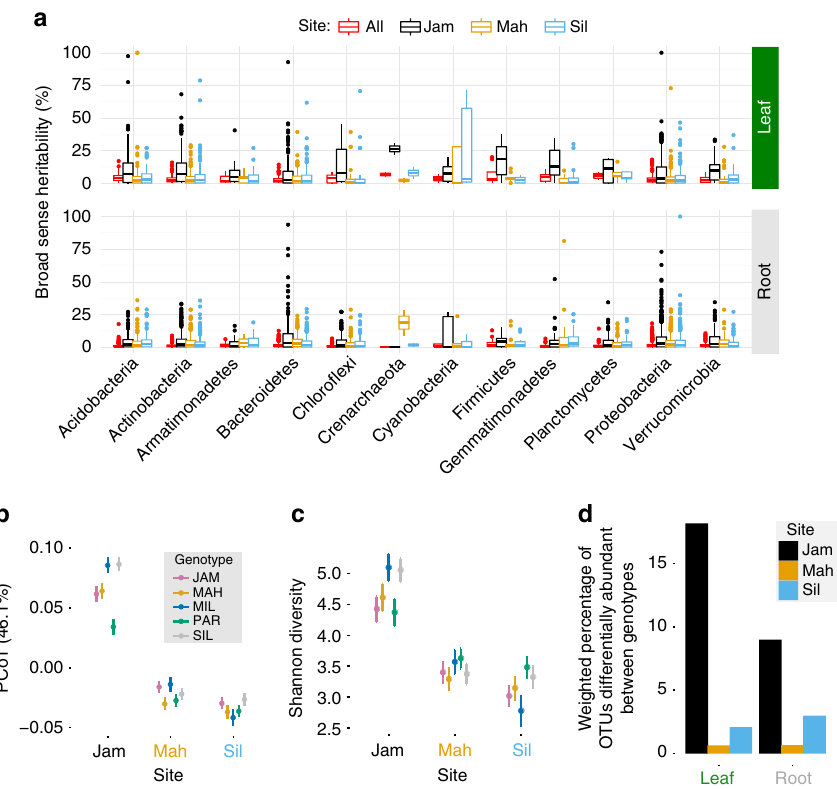
Figure 6 | Host genetic control of the bacterial microbiome differs among habitats. Sample sizes are N ¼ 306 for leaves and N ¼ 310 for roots. ( a ) Estimates of broad-sense heritability ( H 2 ) of individual OTUs are plotted for leaves (top) and roots (bottom). The bottom and top edges of the boxes mark the 25th and 75th percentiles (that is, first and third quartiles). The horizontal line within the box denotes the median. Whiskers mark the range of the data excluding outliers that fell more than 1.5 times the interquartile range below the first quartile or above the third quartile (dots). ( b ) Between-sample diversity of the leaf microbiome is plotted as least-squares mean PCo1 of the weighted UniFrac distance for each plant genotype in each site, showing the genotype-by-site interaction after controlling for other sources of variation in a LMMs, including the constitutive effect of plant genotype and average site effects; F 8,257 ¼ 4.53, P ¼ 0.00011. Bars depict one standard error of the mean. ( c ) Least-squares mean leaf Shannon diversity is plotted for each genotype and each site, revealing site-dependent differences in the relative leaf community richness among host genotypes; F 8,261 ¼ 2.33, P ¼ 0.04. Bars show 1 s.e.m. ( d ) The total relative abundance of OTUs that were predicted by site-specific genotype effects in NBMs is shown for leaves and roots in each site (Wald test, P o 0.05 after Benjamini–Hochberg correction for multiple